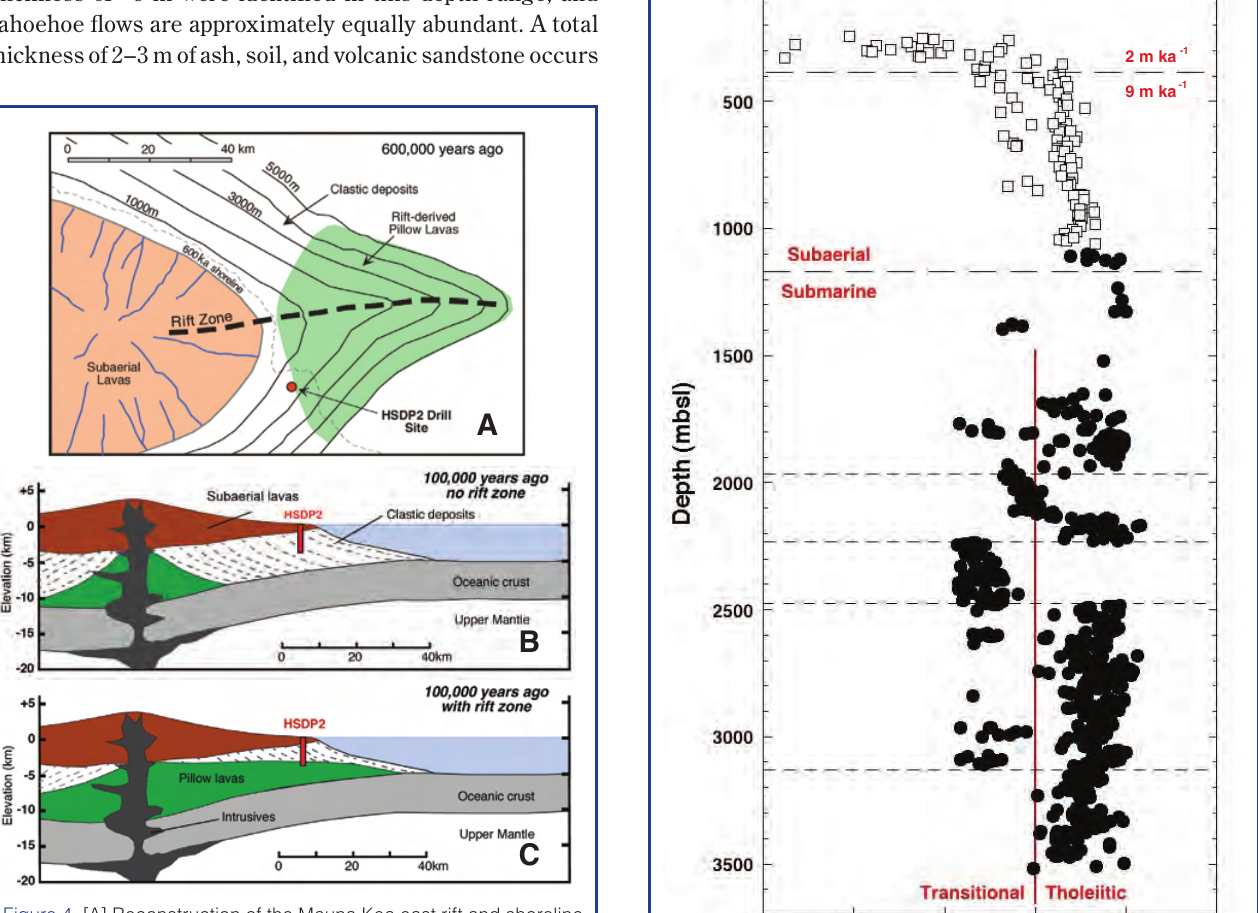
Figure 4. [A] Reconstruction of the Mauna Kea east rift and shoreline at about 600 ka. The shoreline was about 12–15 km NW of the drill site, and the surface at the drill site location was at about 1500 m water depth. Prior to the time depicted, the drill site location would have been receiving submarine lavas from the (hypothesized) Mauna Kea east rift. Subsequently, it was receiving mainly clastic material derived from the shoreline. Since 600 ka there has been about 1500 m of subsidence, so the depth in the HSDP drillcore corresponding to this map is about 3000 mbsl. Below this depth, the rocks encountered in the drillcore should be exclusively submarine pillow lava. The distribution of submarine pillow lava is based on the interpretation of Kilauea’s east rift zone bathymetry by Moore (1996). [B] Schematic cross section from the Mauna Kea summit through the HSDP2 drill site (in red), model for 100 ka ago: assuming that there is no rift zone. [C] In this model the HSDP2 core hole should not have intersected any pillow lava, assuming the presence of a rift zone, which fits the observations